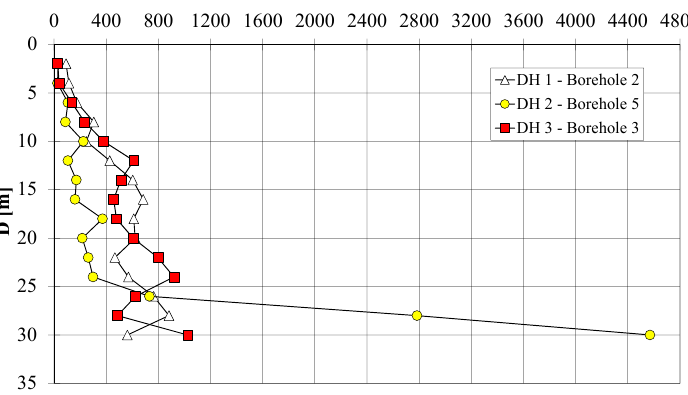
Figure 10. Shear modulus values of G 0 from down-hole tests.